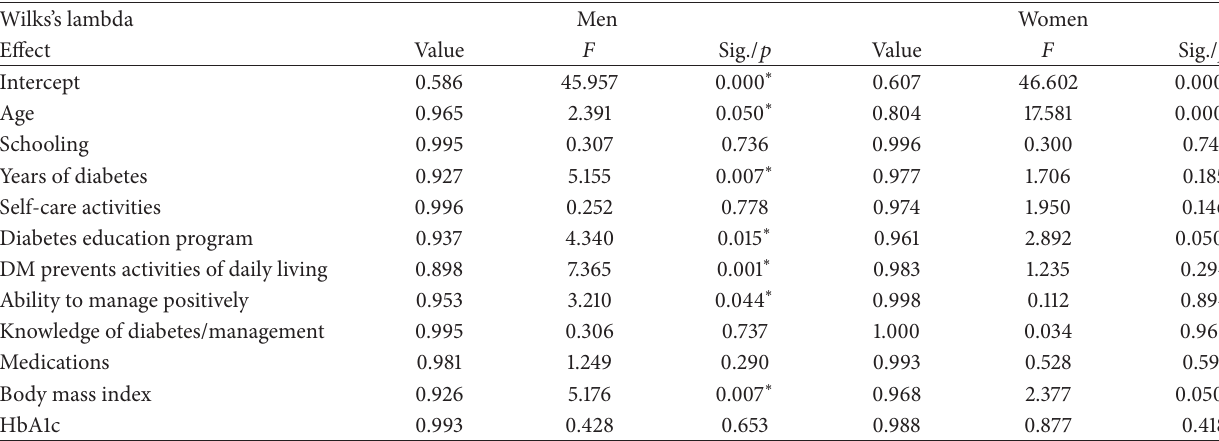
Table 4: Combined effect of predictors on QoL and health state: multivariate